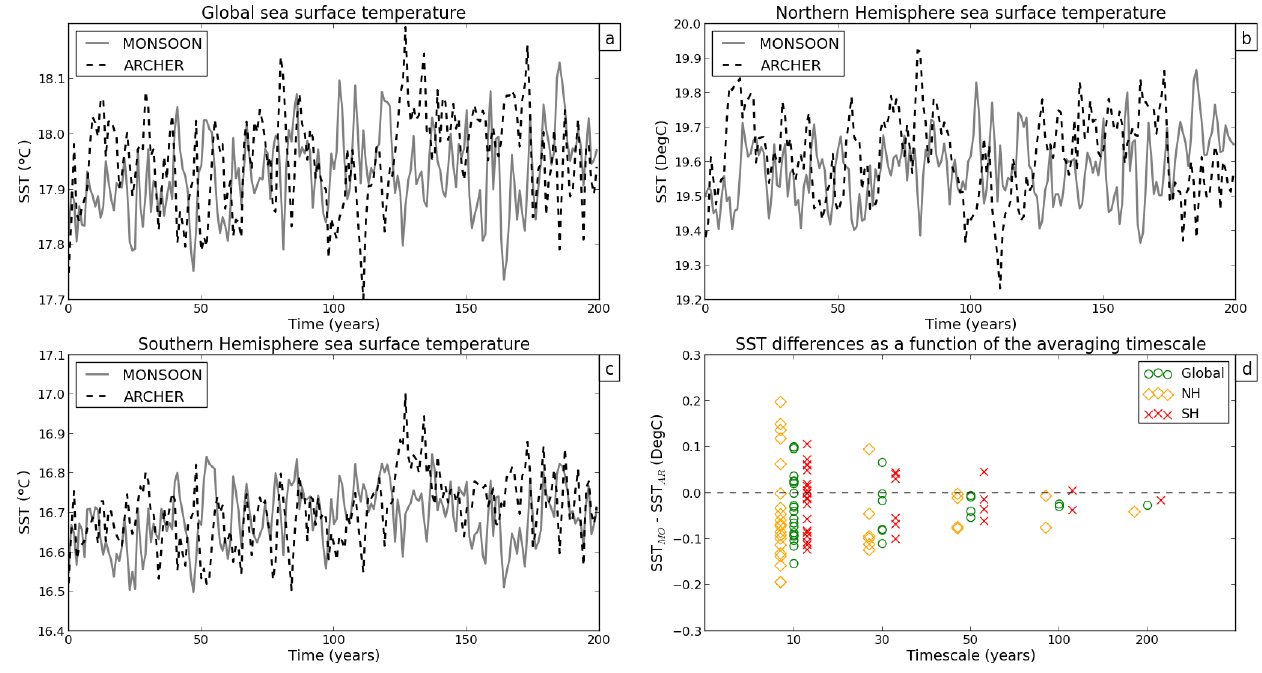
Figure 4. Annual mean time series of global SST (a) , Northern Hemisphere SST (b) , and Southern Hemisphere SST (c) for PI MO (grey line) and PI AR (dashed line). Panel (d) shows how SST differences vary as a function of the timescale.